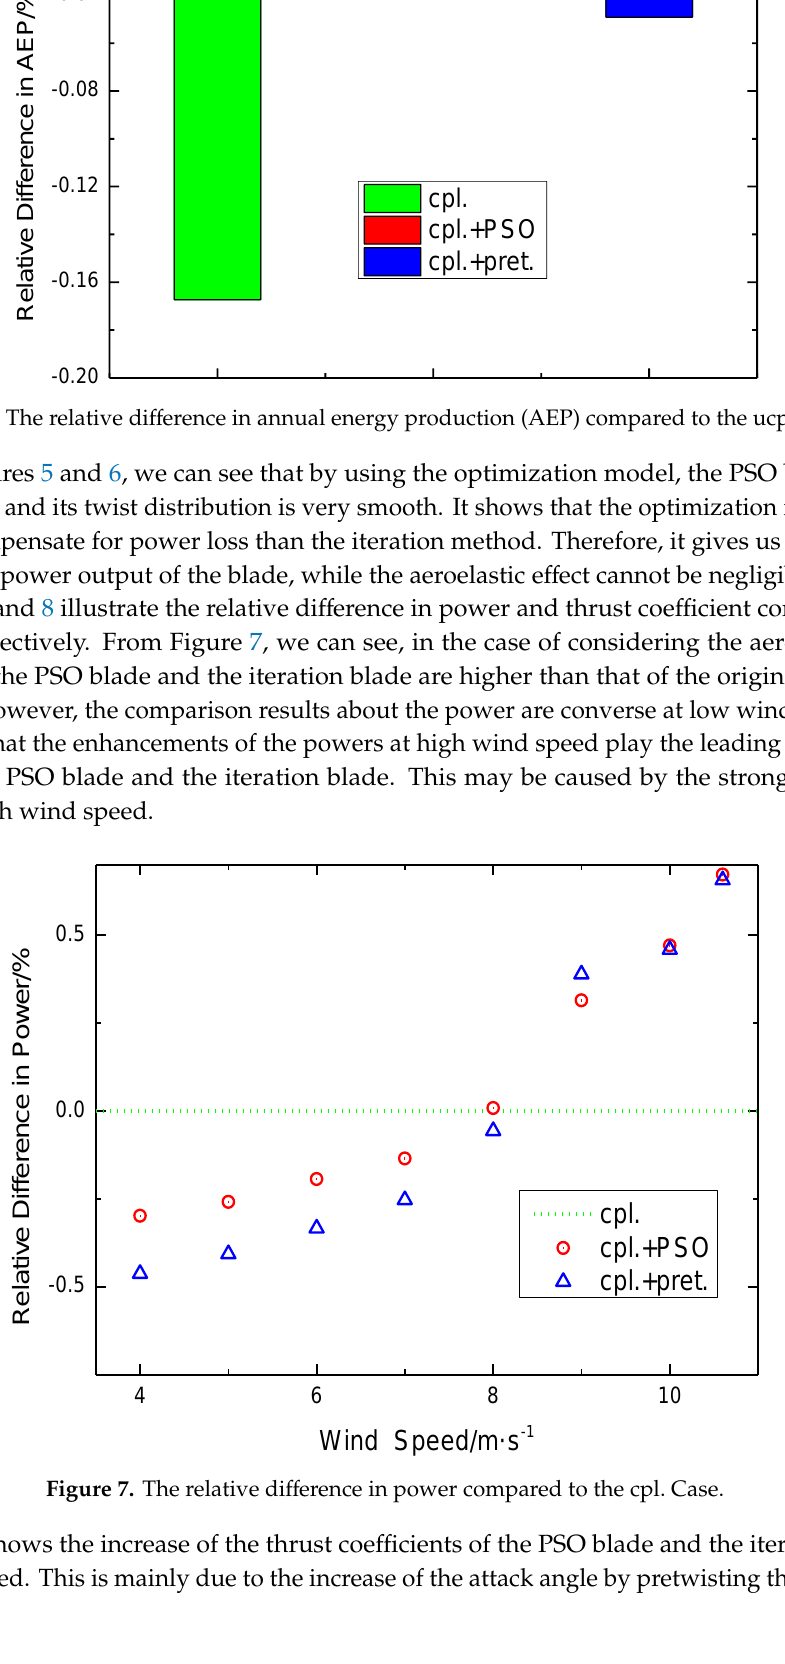
Figure 5. Twist distribution along the blade.